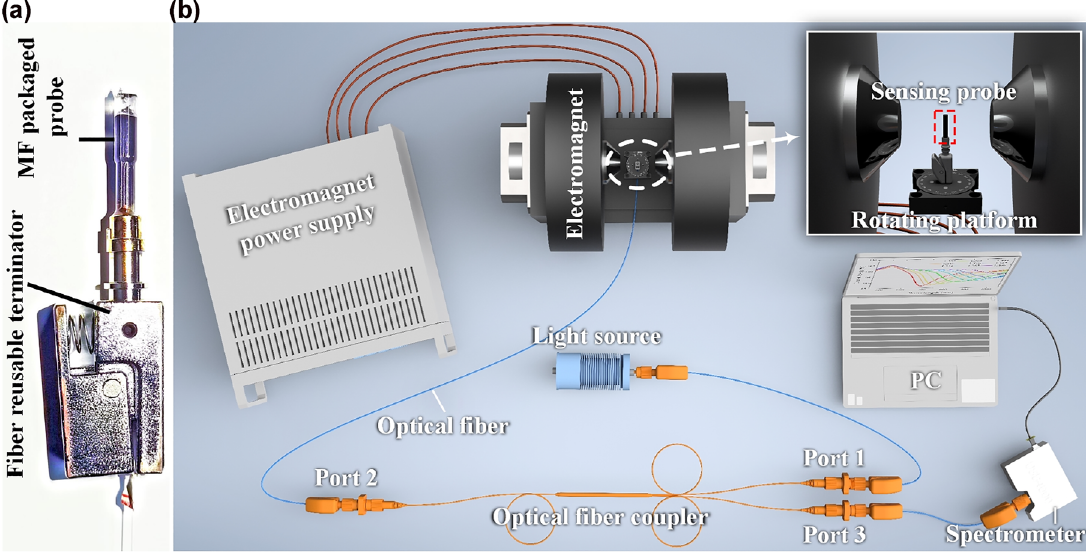
Figure 10: Photograph of sensor and schematic diagram of the experimental setup: (a) Photograph of the as-fabricated sensing probe. The wedge-shaped sensing tip is placed in a plastic tube with MF and then sealed with UV glue and fixed at the top of the ‘‘fiber reusable terminator’’; (b) Diagram of the experimental setup for investigating the sensing properties.